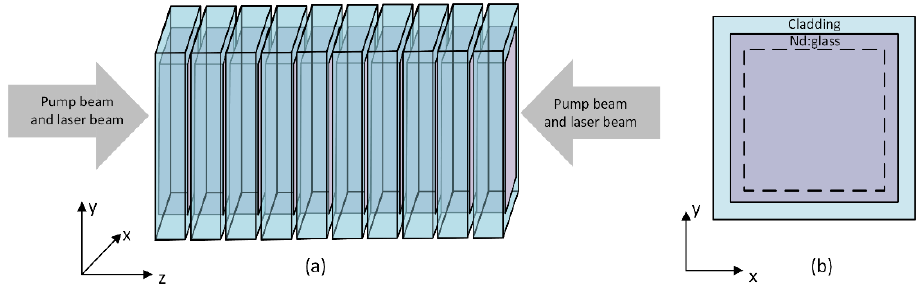
Figure 2. ( a ) Configuration of a multislab Nd: glass laser head and ( b ) a diagram of a monolithic gain slab. The pump area is in the dashed box.